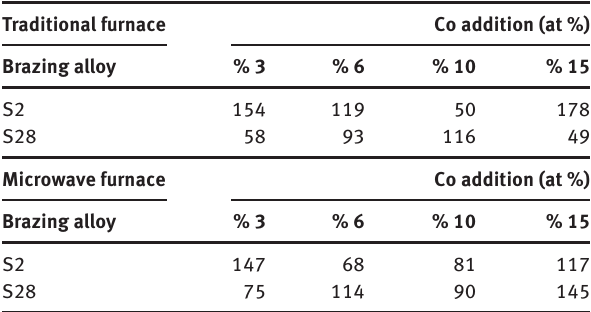
Table 2 Shear strength values of brazed samples in traditional and microwave furnaces.